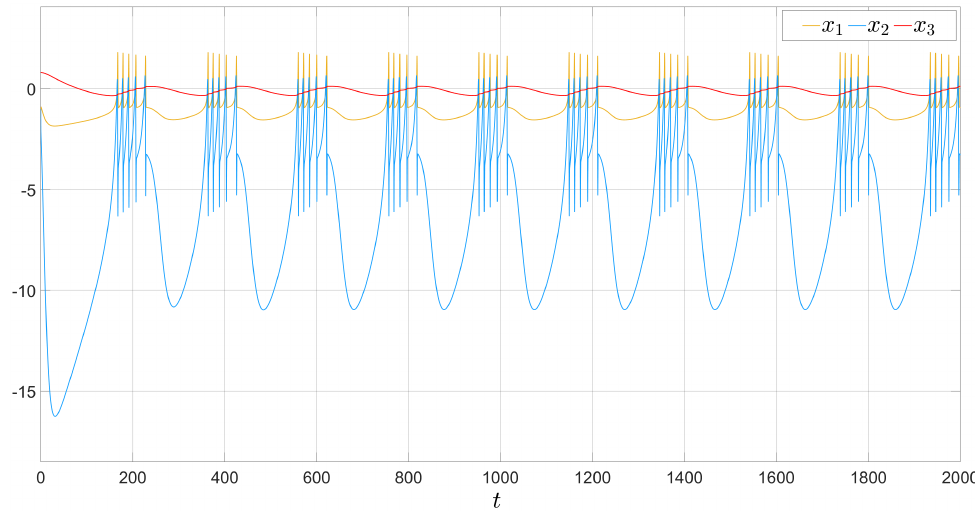
Figure 1. Regular bursting, b = 3, r = − 1, ε = 0.003, I = 0.